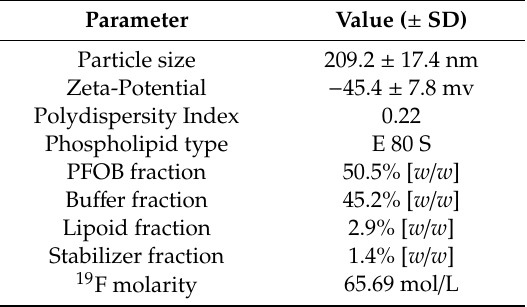
Table 1. Basic properties of the applied PFOB-NE.